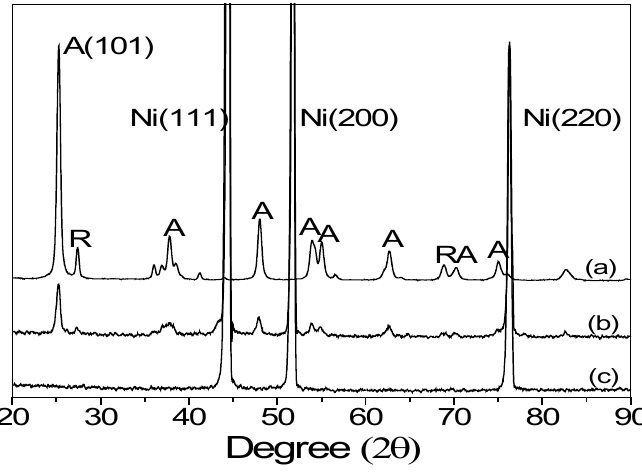
Figure 3. XRD pattern of Degussa P25 TiO substrate ( c ). A and R denotes the anatase and rutile crystal phases,